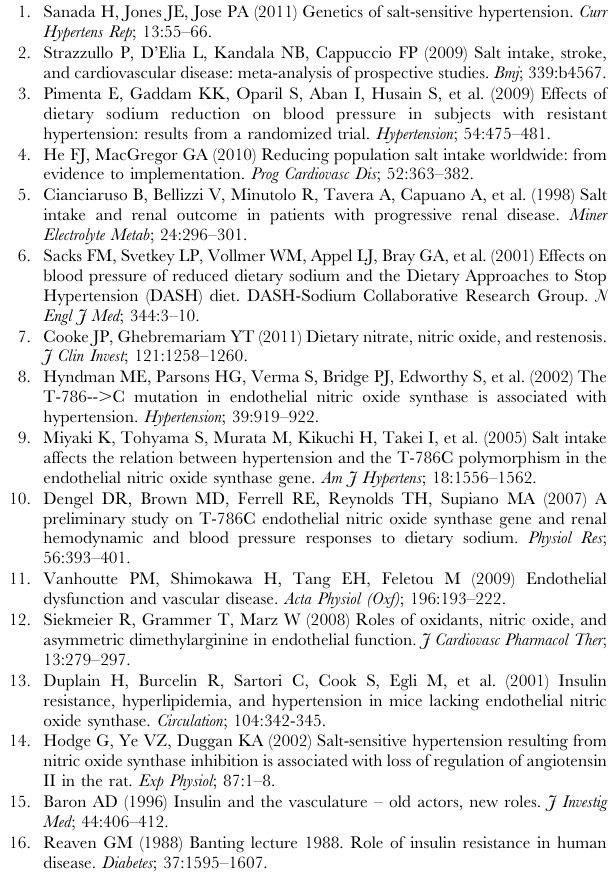
Figure S5 The effect of INT-747 treatment on the expression of c-JNK isoforms 1 and 2 in the Liver. Animals were fed low (control)- or high-salt diet and treated with vehicle or INT-747 at 10 or 30 mg/kg/day for 6 weeks. Liver lysates were compared for c-JNK1 and 2 expression by Western blot. The c-JNK expression was normalized to b -Actin (ACTB). C-JNK=c-Jun N- terminal Kinase. Data is expressed as Mean 6 SEM. (*p , 0.05 versus the data of low-salt or high-salt diet and INT-747 treated with either dose. ANOVA followed by Bonferroni